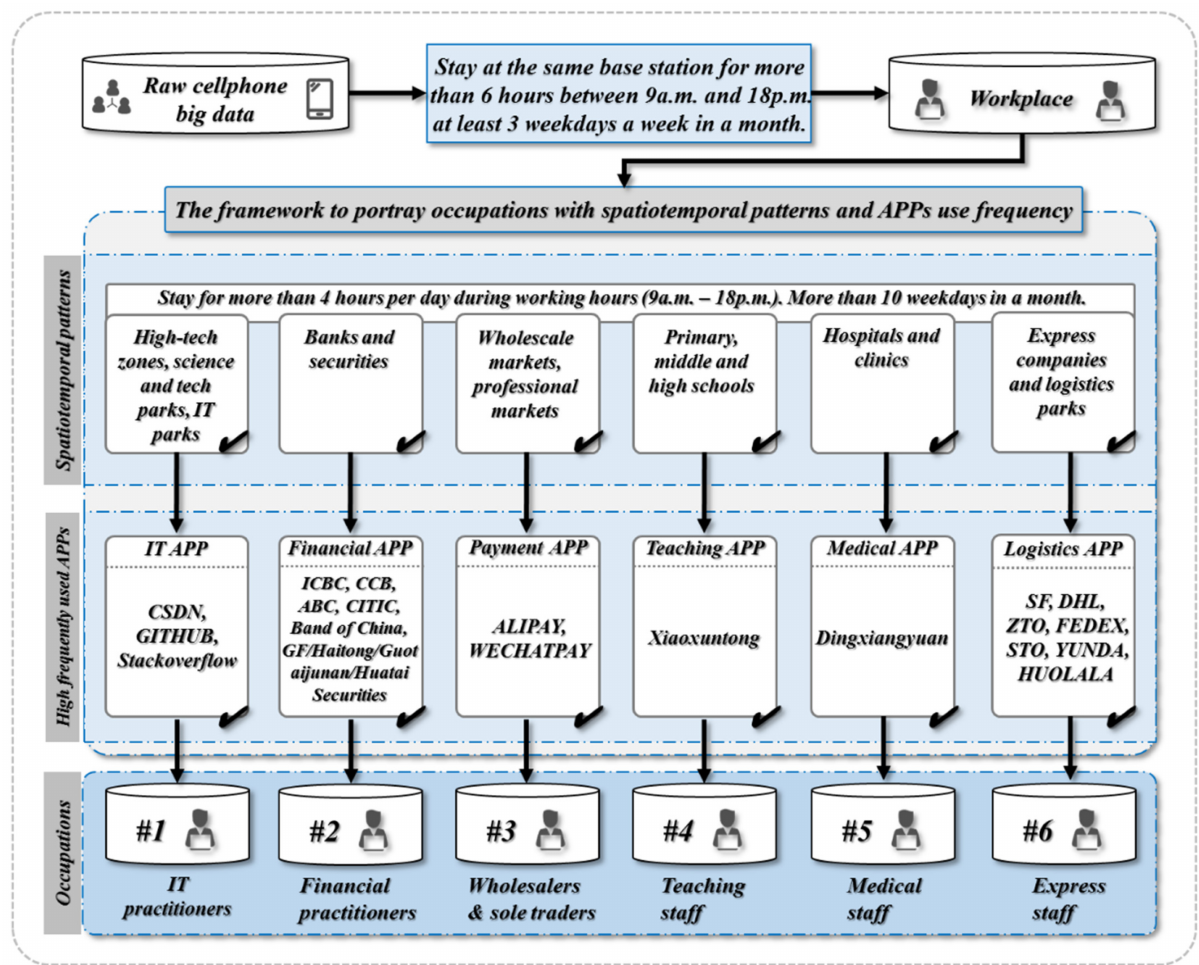
Figure 3. Workflow of workplace identification and occupation